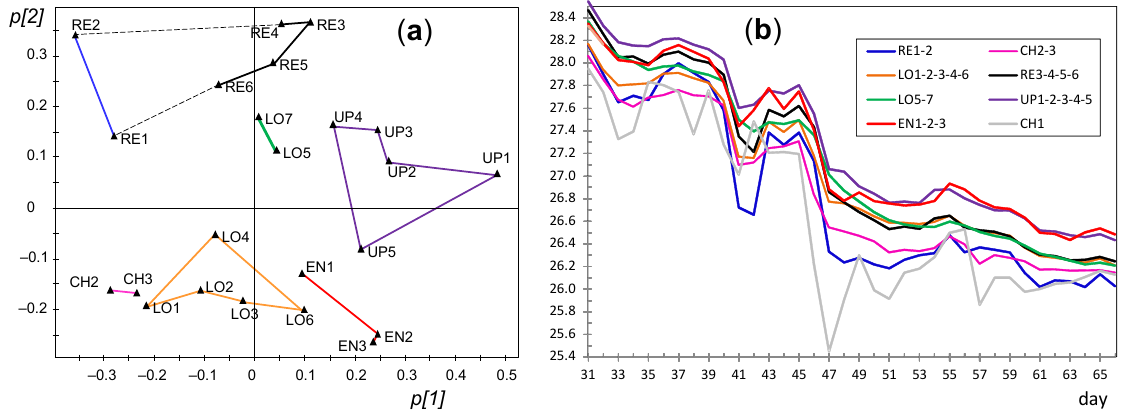
Figure 20. PCA of daily medians for the period of days 31–66 after discarding nodes CH1, OUT, and SAC: ( a ) loading plot for PC1 and PC2 ( p[2] vs. p[1] loadings), ( b ) time series of daily median temperatures from day 31–66. Trajectories were averaged according to clusters indicated in ( a ).